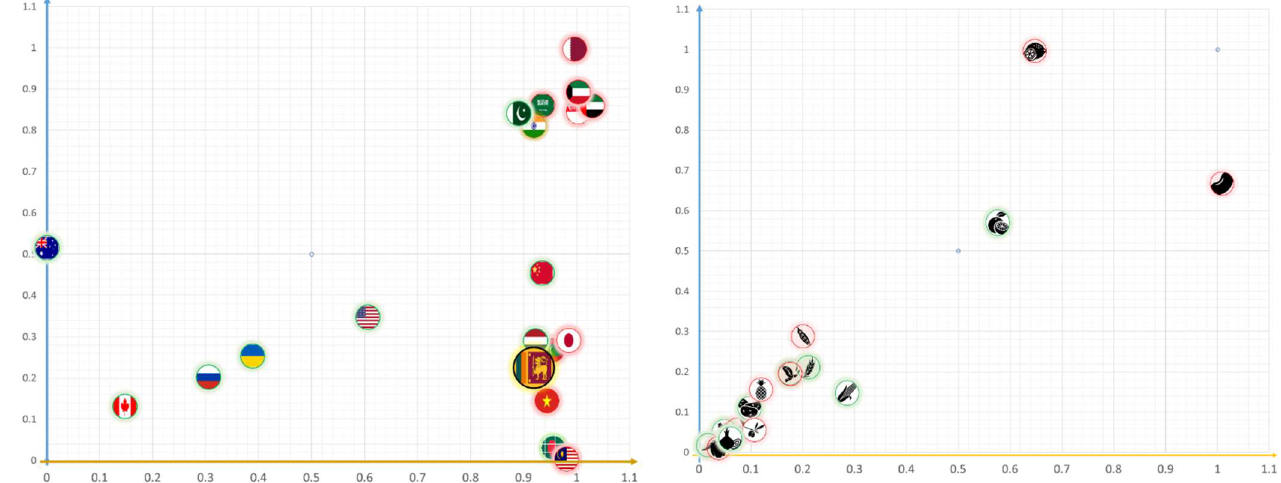
Figure 19. Water and land stress for trade partners (on left ) and embodied water and land contents for the top crop trades (on right ).